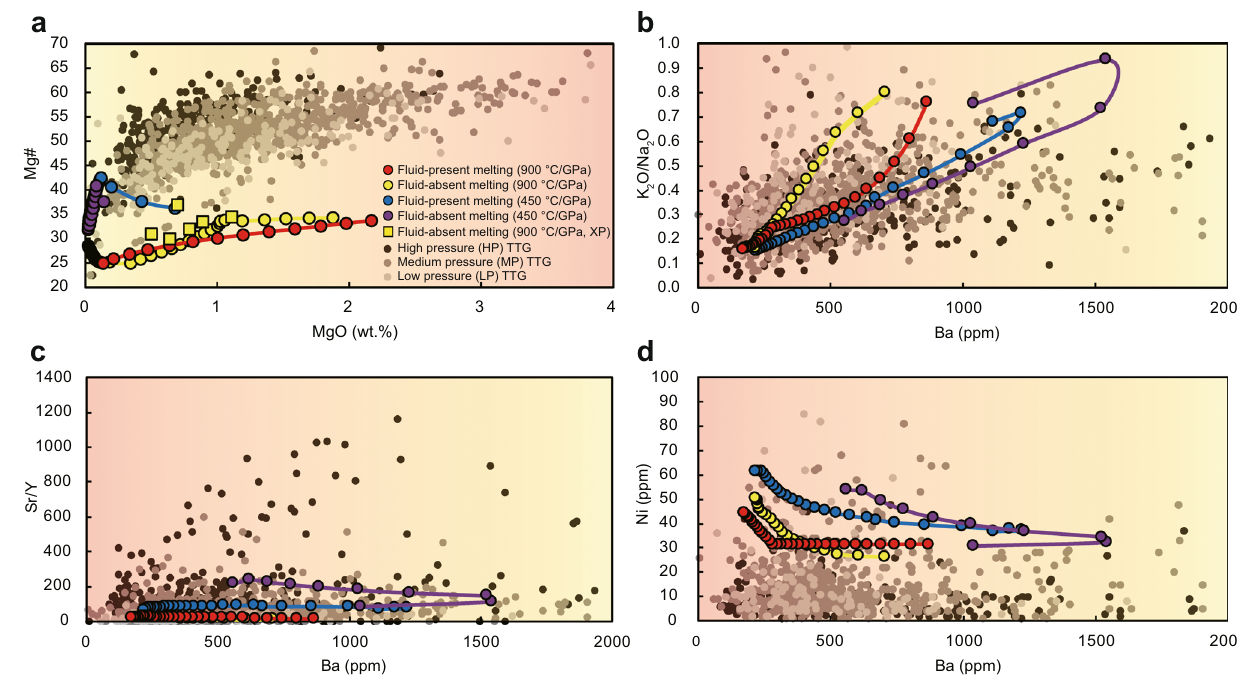
Fig. 3 | Modeled tonalite – trondhjemite – granodiorite (TTG) melts composi- tions.a Mg# versus MgOcontent of modeled melts, experiment data from similar protolithcompositionwas also plotforcomparison 13 . Numbersinthelegend show thethermalgradient.XPindicatesexperimentalresults. b – d K 2 O/Na 2 O,Sr/Y,andNi